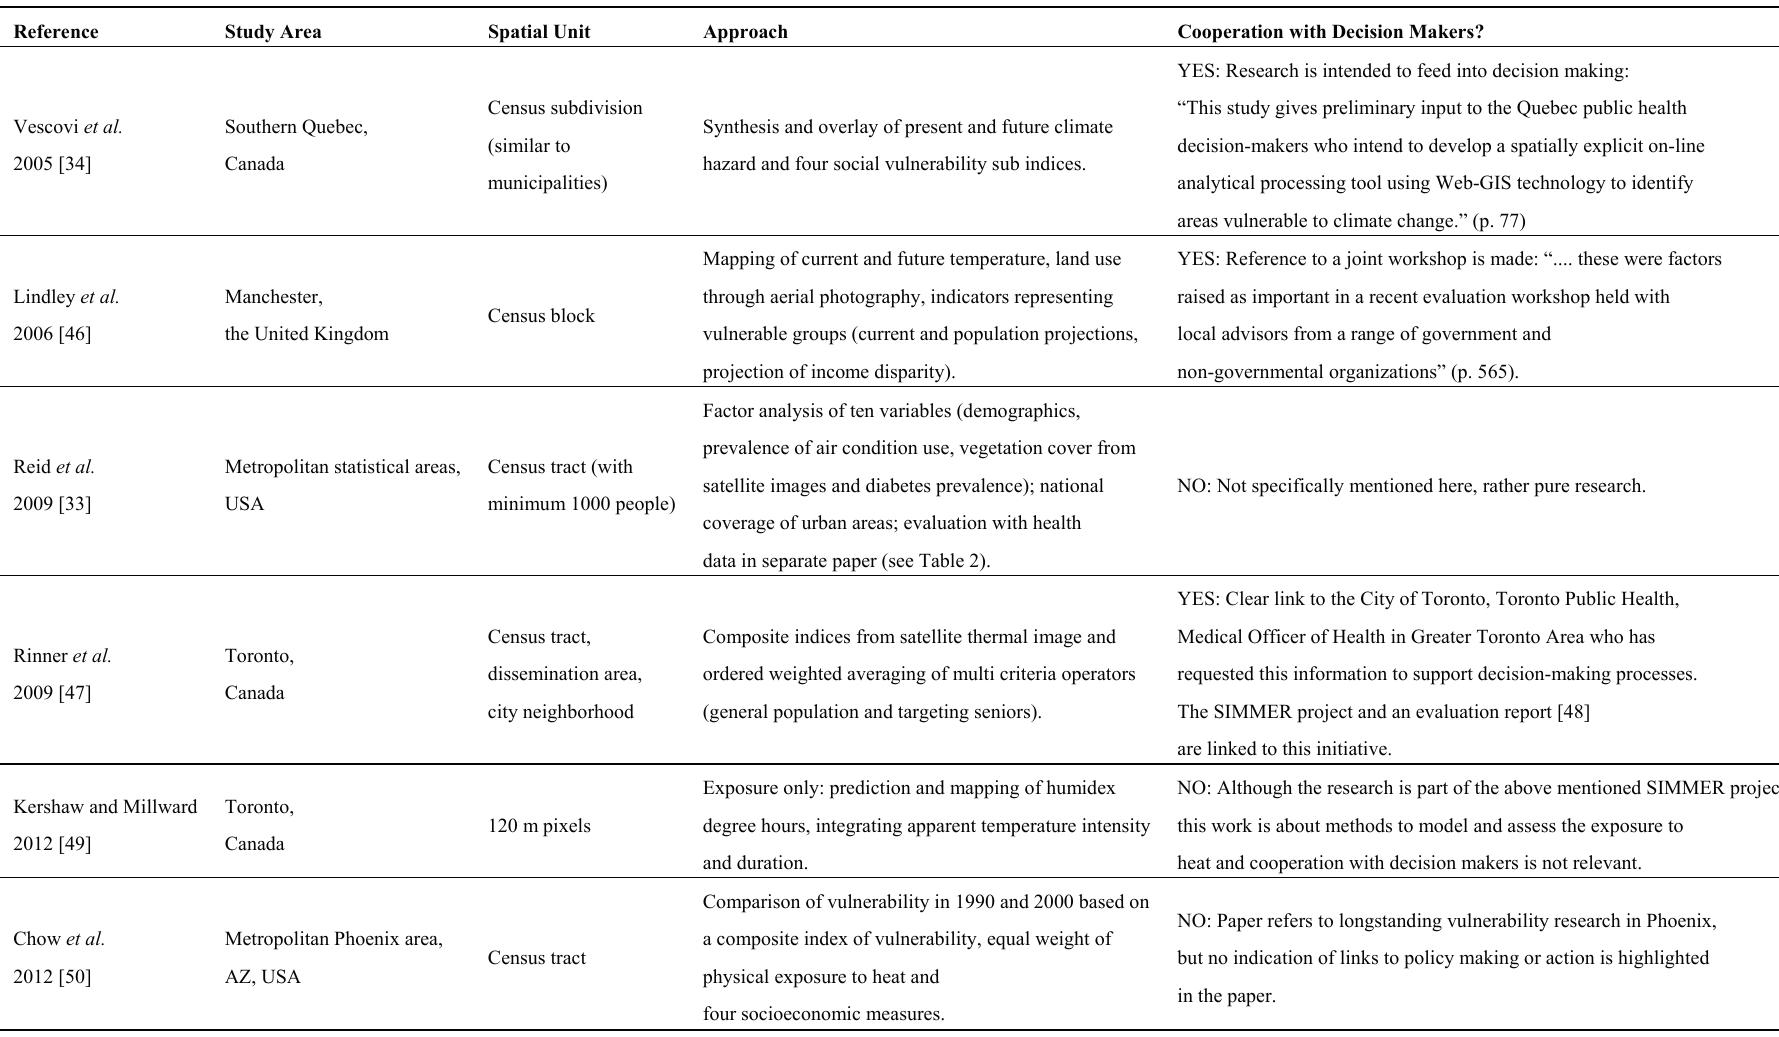
Table 1. Papers on “ a-priori ”/inductive heat vulnerability